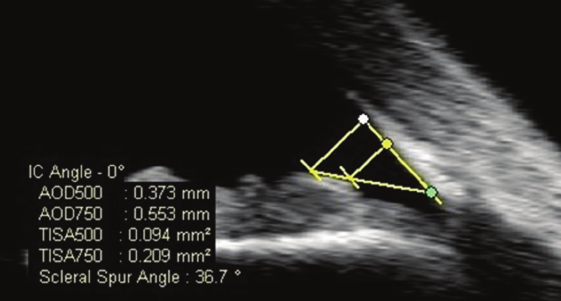
Figure 1: AS-OCT (anterior segment optical coherence tomogra- phy): quantitative measurements of angle parameters: green dot: scleral spur, connecting point between the posterior curvature of the cornea and the curvature of the sclera. yellow dot: linear distance of 500 um anterior to the scleral spur which marks the location of the trabecular meshwork, white dot: linear distance of 750 um anterior to the scleral spur which covers a more extensive area surrounding the trabecular meshwork. AOD 500 and AOD 750: Linear distance from the cornea to the iris at 500 and 750 um from the scleral spur, respectively. TISA 500 and TISA 750: Area of trapezoid between iris and cornea from sclera to 500 um and 750 um,